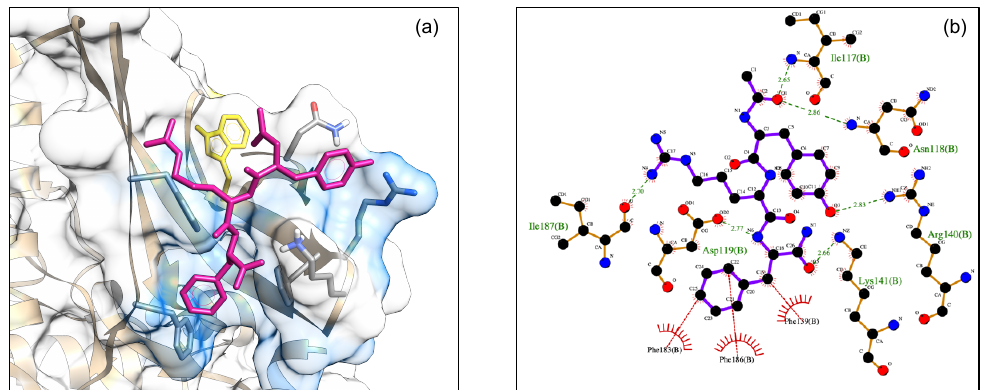
Figure 8. ( a ) Surface model of DTP3 docked to BP3 (cyan) where the protein molecule is shown as surface and DTP3 is shown in stick (magenta). Trp135 located in proximity of the DTP3 binding site is depicted as yellow sticks; ( b ) Interactions of the MKK-KD residues with DTP3 interactions of the MKK-KD residues with DTP3 are displayed in a two dimensional model. The main interactions between the protein and the ligands are shown as dotted lines, hydrogen bonds are in green, while the hydrophobic interactions are shown in